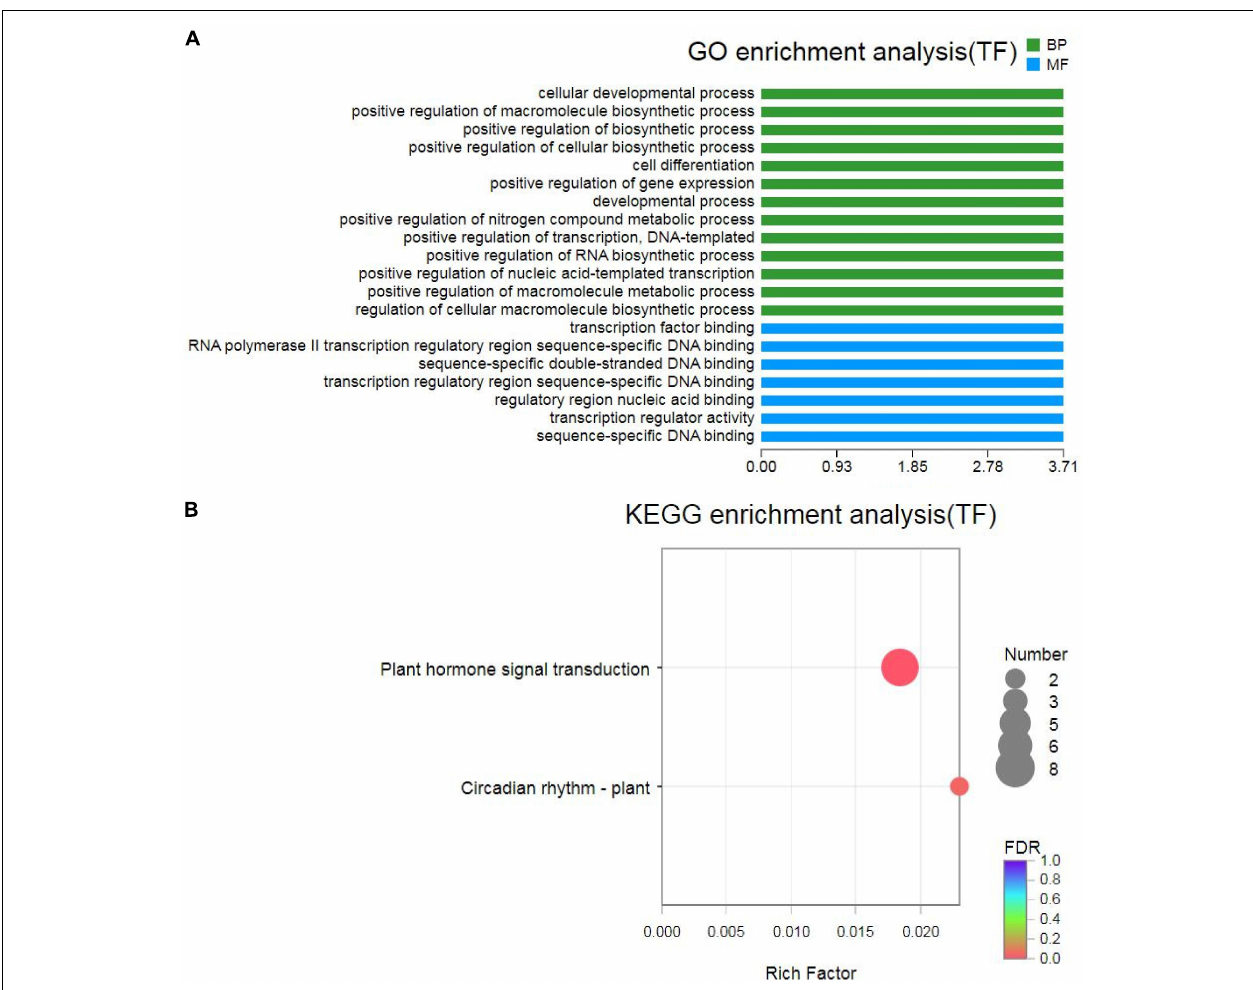
FIGURE 12 | Gene Ontology and KEGG analysis of TFs. (A) GO analysis of TFs; (B) KEGG analysis of